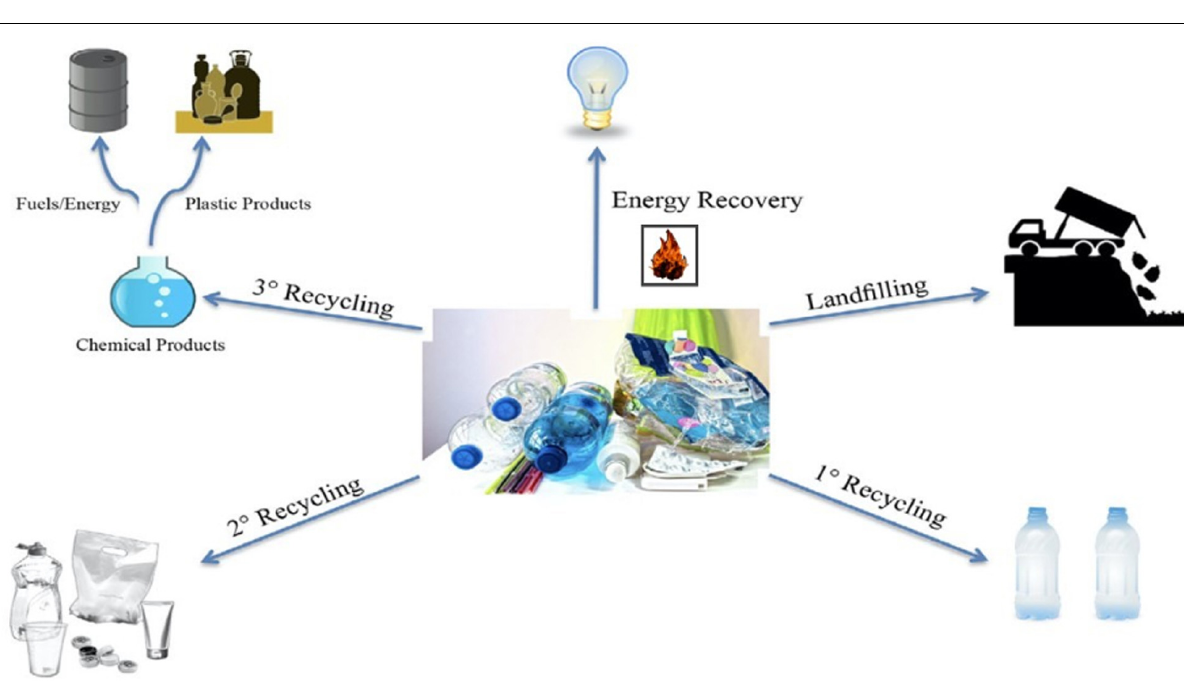
FIGURE 2 | Usual destination for current plastic waste. Recycling classifications: 1 ◦ Recycling—primary—turning uncontaminated discarded plastics into the same new product, without the loss of properties. 2 ◦ Recycling—secondary—mechanical recycling, where the polymer is physically reprocessed and generally used for a different purpose than its original use. 3 ◦ Recycling—tertiary—chemical recycling, where chemical processes are used to break down the polymer into added-value products, and energy recovery—polymers are incinerated and energy is recovered in the form of heat (Thiounn and Smith, 2020). Reproduced with